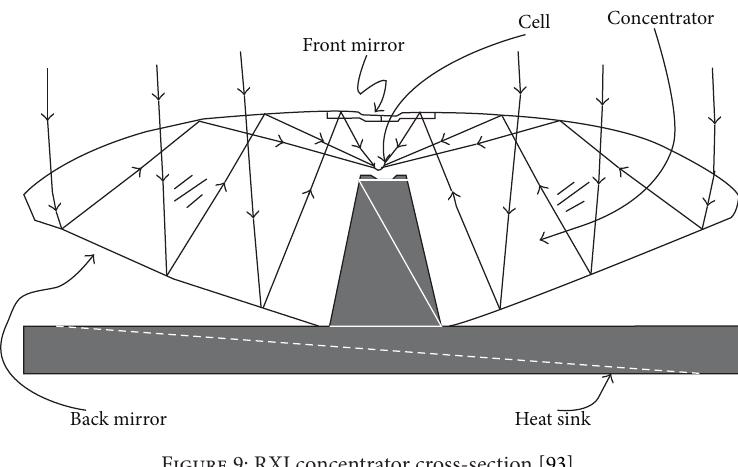
Figure 9: RXI concentrator cross-section [93]. Table 3: Advantages and disadvantages of solar